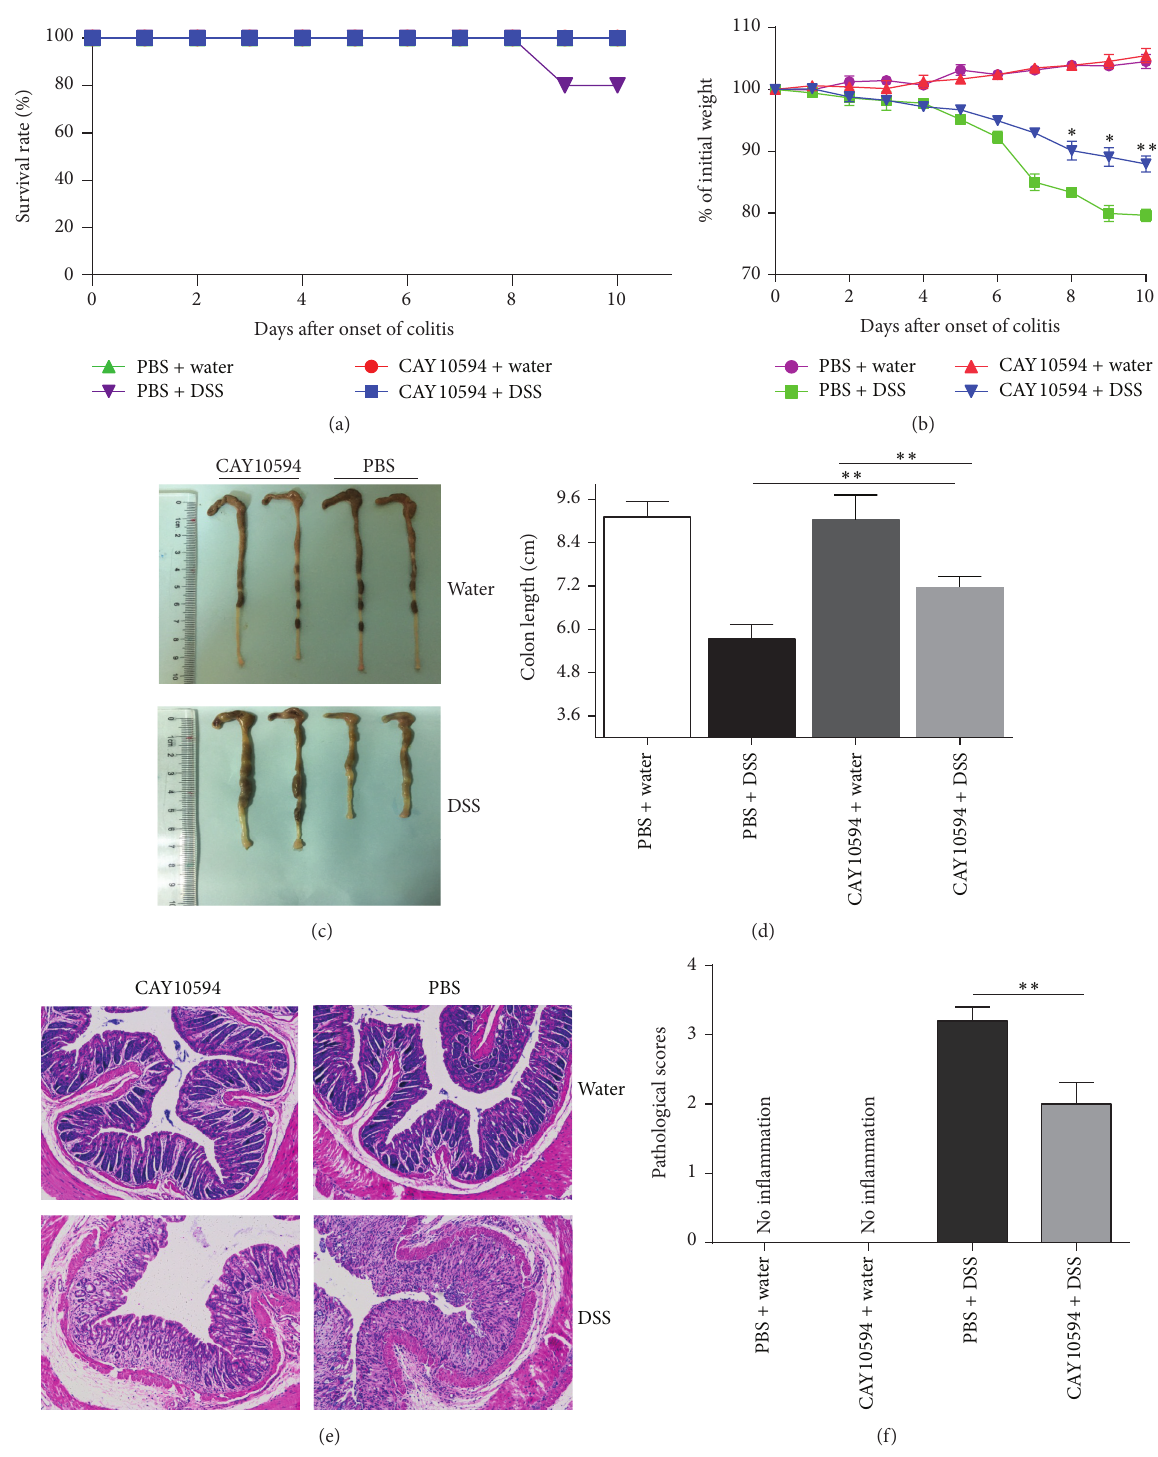
Figure 5: Blockade of PLD2 alleviates DSS-induced colitis in mice. DSS-induced colitis in C57BL/6 mice was induced as indicated. Two groups of DSS-exposed mice ( 𝑛 = 10 ) were treated with PLD2 inhibitor (CAY10594, 4 mg/Kg) or PBS as controls daily by oral gavage. Two groups of none DSS-exposed mice ( 𝑛 = 10 ) were also treated with CAY10594 or PBS as negative controls. (a) The survival rates of mice after DSS exposure over 10 days. (b) The changes of body weight were observed and expressed as a percentage of initial body weight at the start of experiments during 10-day observation. (c) Gross morphology of colonic tissues on day 10 after DSS induction. (d) The statistical length of colons in different groups. ∗ 𝑝 < 0.05 and ∗∗ 𝑝 < 0.01 versus controls. (e) Representative H&E staining images of colonic sections ( × 200). (f) The changes in pathological scores from colonic sections were calculated as indicated. ∗ 𝑝 < 0.05 and ∗∗ 𝑝 < 0.01 versus